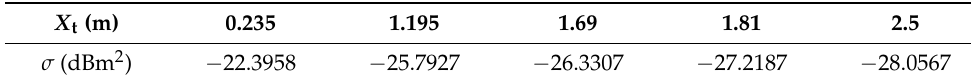
Figure 11. Stealth optimization: X n = 0 m; α m = 50 ◦ ; F rh = 6 GHz; β = 0 ◦ . Table 3. RCS of the vertical